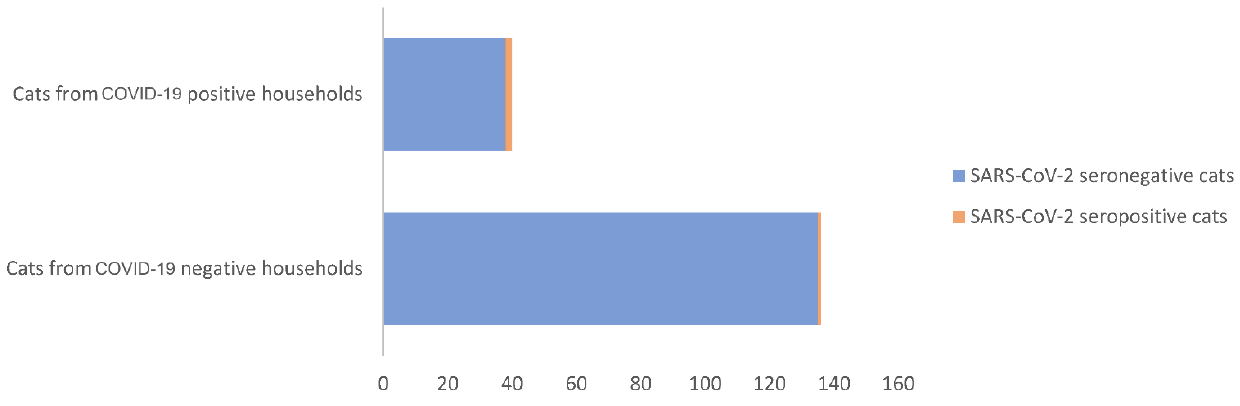
Figure 2. SARS-CoV-2 seropositivity among cats from COVID-19-positive and -negative households. Table 2. Characterization of sampled cats. n = 176; otherwise, n value is